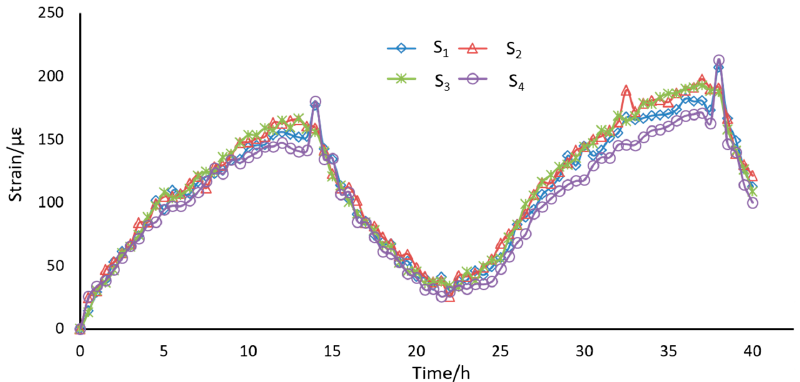
Figure 5. The long-term stability of the designed sensors.